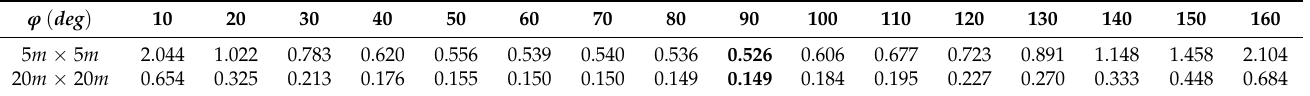
Table 1. The 2D RMSPE ∆ p (m) with varying ϕ in the 5 m × 5 m and 20 m × 20 m environments for the LOS condition.